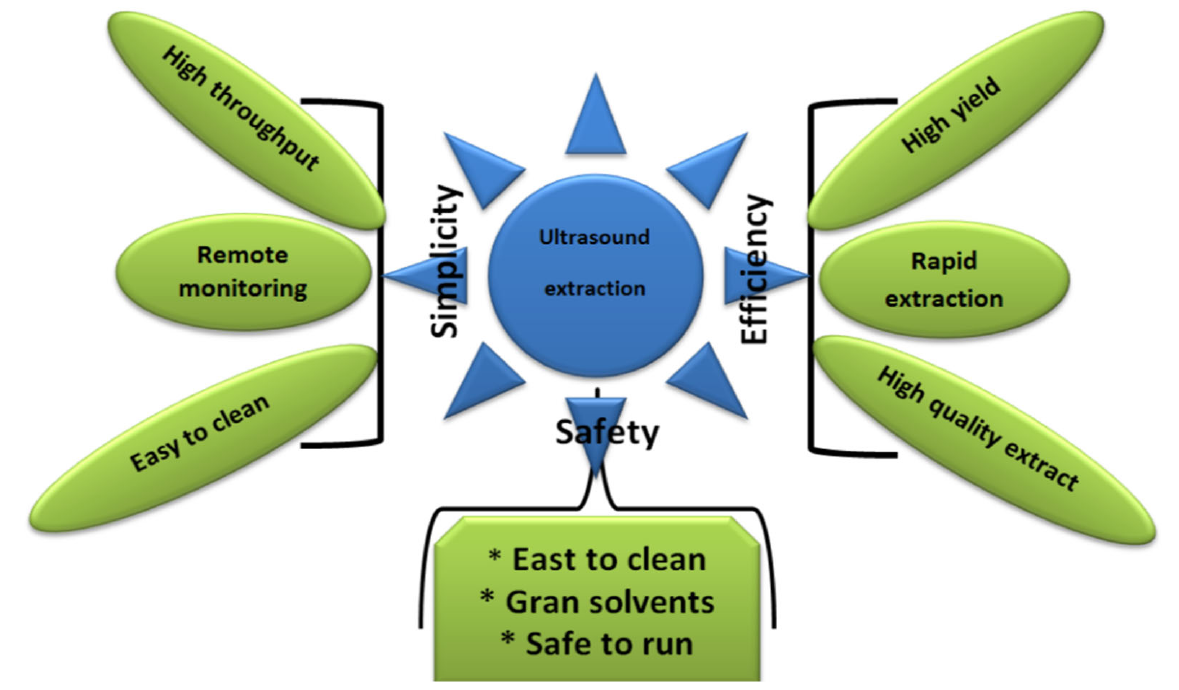
Figure 2. The bene fi ts of using ultrasound technology in order to extract desired compounds. Figure 2. The benefits of using ultrasound technology in order to extract desired